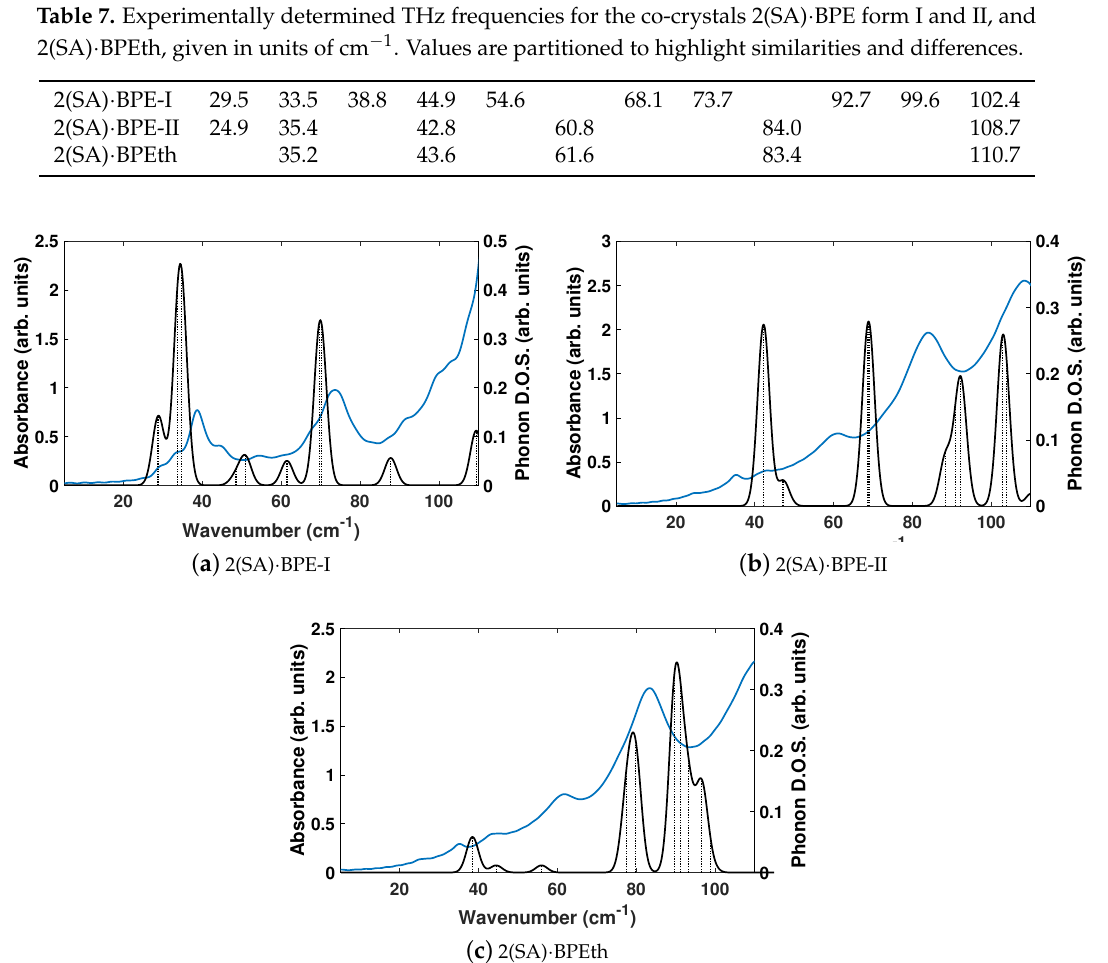
Figure 9. Shown here are comparisons of the computed phonon modes (black solid curves) to experimentally obtained THz spectra (solid blue curves) of ( a ) 2(SA) · BPE-I; ( b ) 2(SA) · BPE-II; and ( c ) 2(SA) · BPEth using DFT-D. Dashed black vertical lines are the normalized phonon mode intensity used to obtain the phonon density of states (DOS). All measurements are given in arbitrary